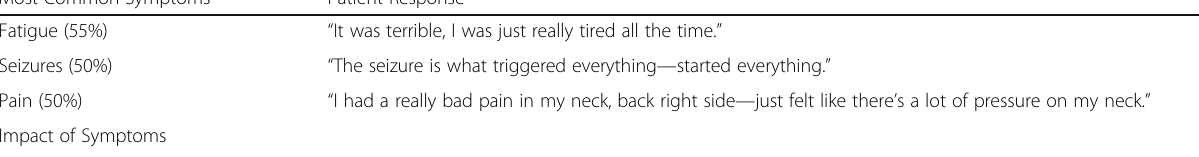
Table 3 Interview Response Narrative Examples from Most Common Symptoms and Impact Most Common Symptoms Patient